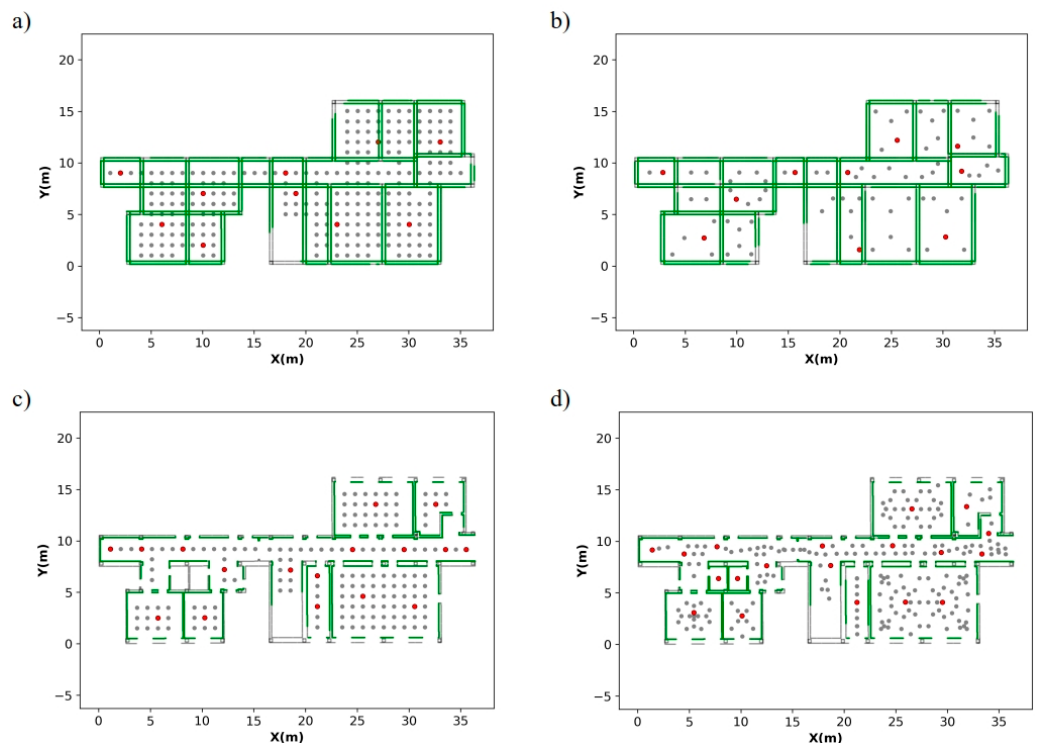
Figure 19. Optimization scan position result in case study 1: ( a ) grid-based method, ( b ) triangulation-based method, ( c ) grid-based with scan positions in doors and ( d ) triangulation-based method with scan positions in doors. Color code: scan positions (red points), candidates scan positions (gray points), acquired elements (green), non-acquired elements (black).